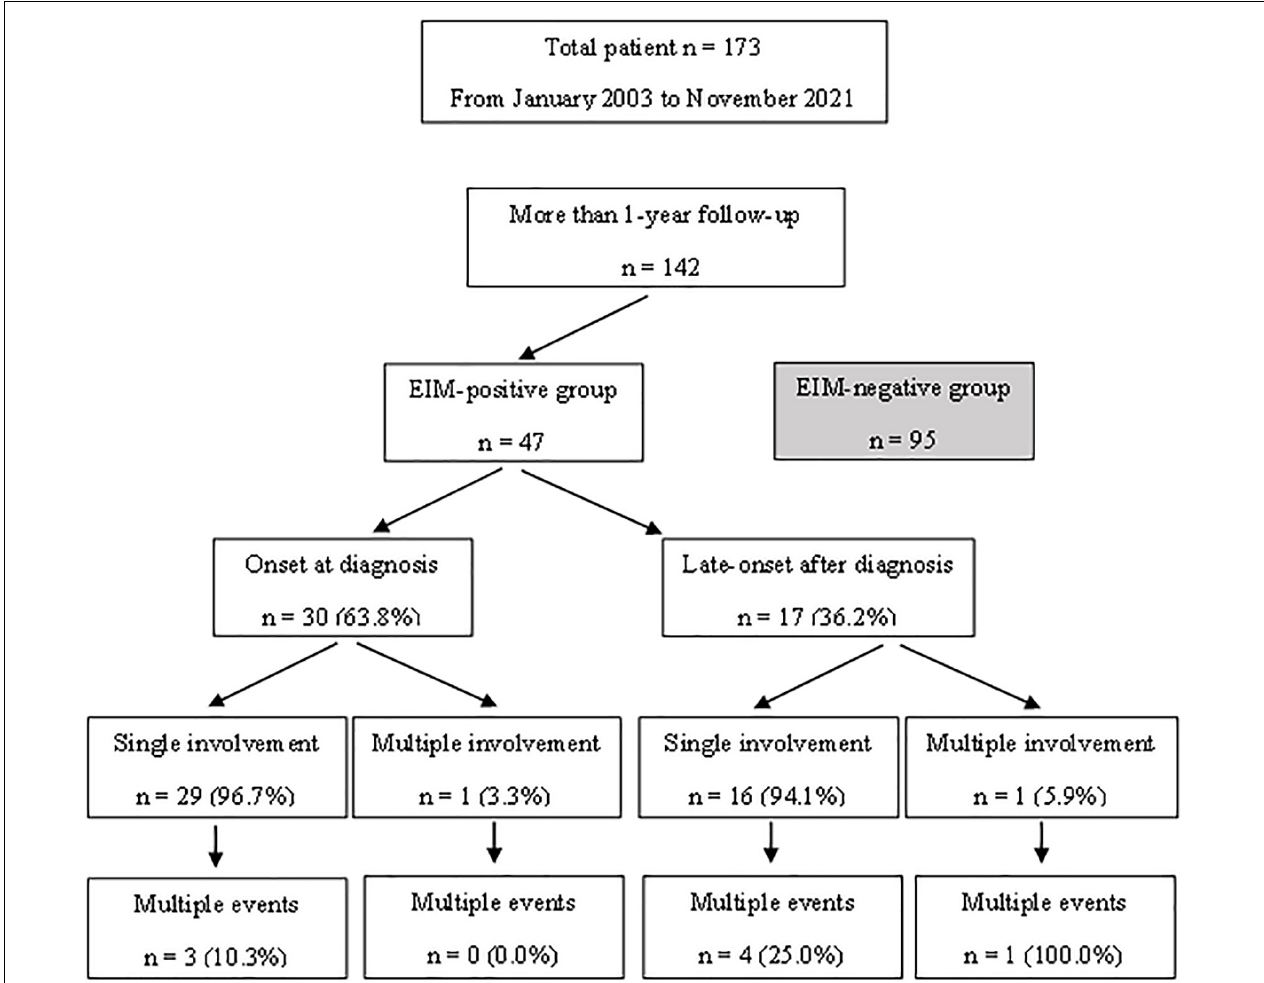
FIGURE 1 | A flow chart diagram showing the subject selection processes and the characteristics of patients with extraintestinal